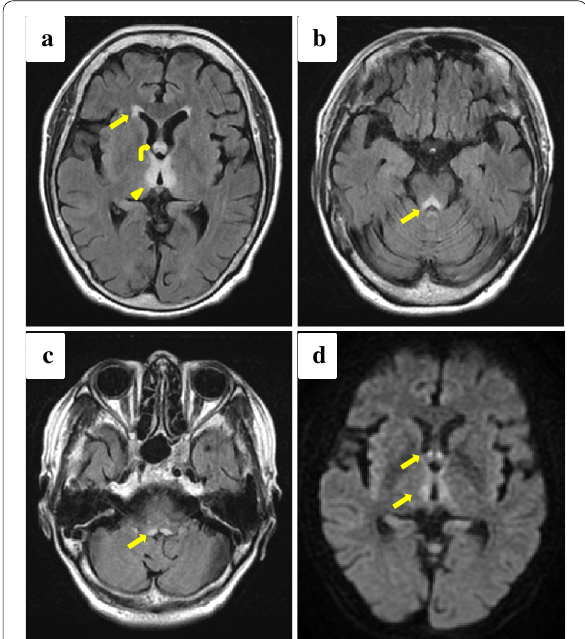
Fig. 1 a – d Contrast-enhanced MRI of the head showing symmetrically abnormal hyperintense signal on FLAIR in the frontal horn of lateral ventricle ( a , arrow), the medial thalami bordering the third ventricle ( a , arrow head), the mammillary bodies ( a , curved arrow), the periaqueductal region of the midbrain ( b , arrow), and the bottom of the 4th ventricle ( c , arrow). DWI imaging showing restricted diffusion corresponding to the FLAIR hyperintensities ( d ,